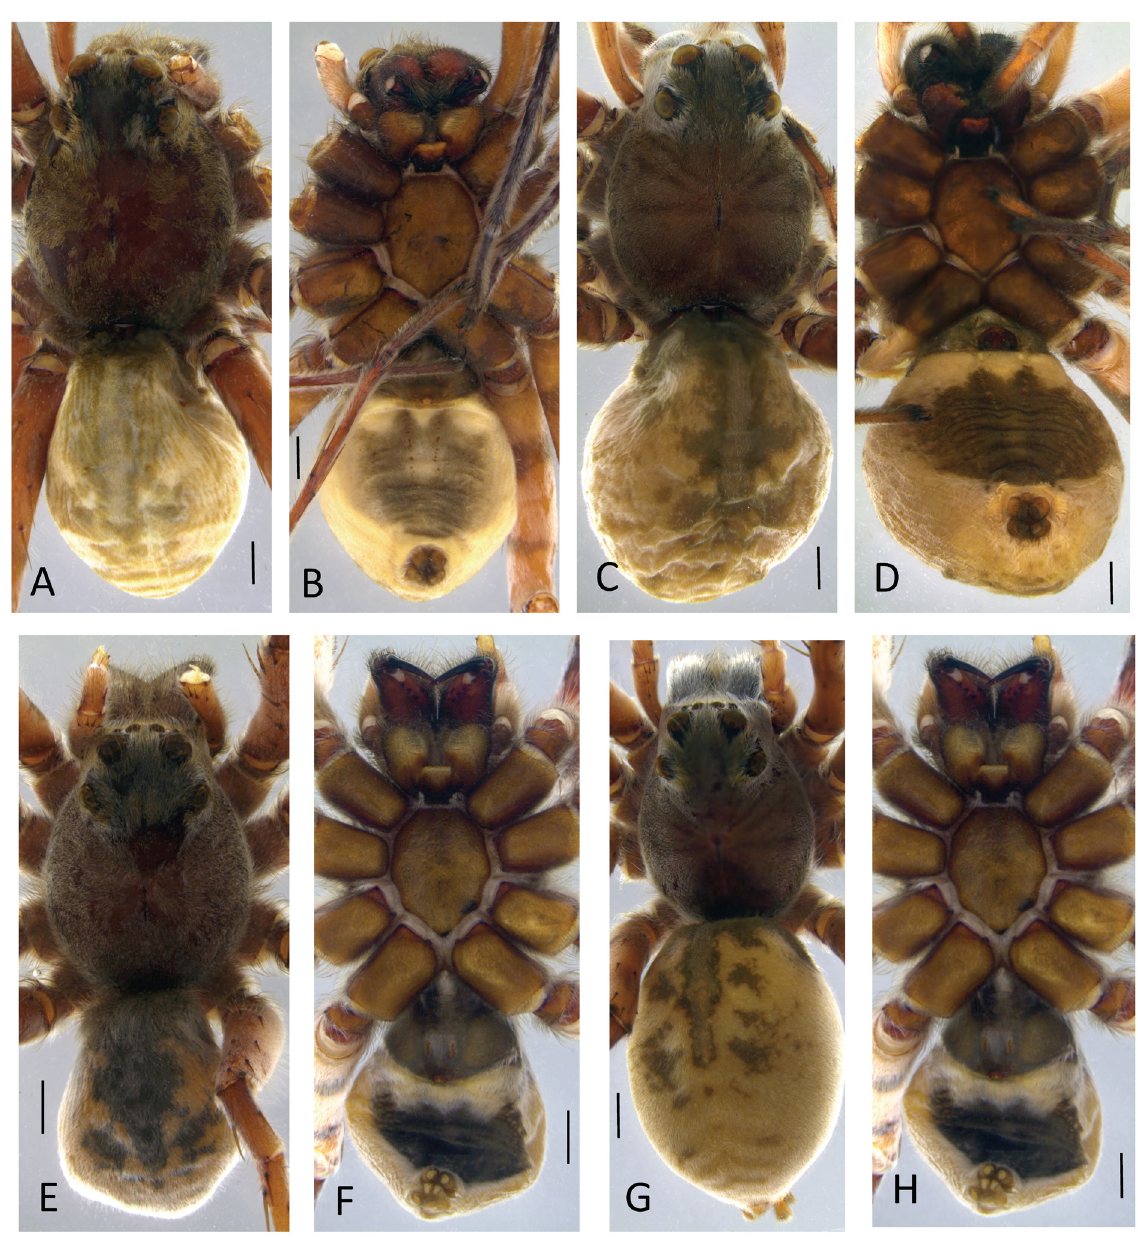
Fig. 26. Tetralycosa Roewer, 1960, microscopic photographs showing dorsal and ventral views. A–B . T. halophila sp. nov. , ♂, holotype (SAM NN21734). C–D . T. halophila sp. nov. , ♀, paratype (SAM NN21733). E–F . T. williamsi sp. nov. , ♂, holotype (SAM NN13812). G–H . T. williamsi sp. nov. , ♀, paratype (SAM NN17385). Scale bars: A–H = 2.00